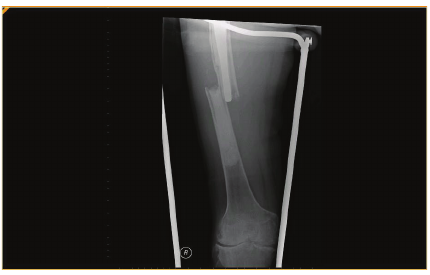
Figure 1: Periprosthetic fracture of right femoral prosthesis.